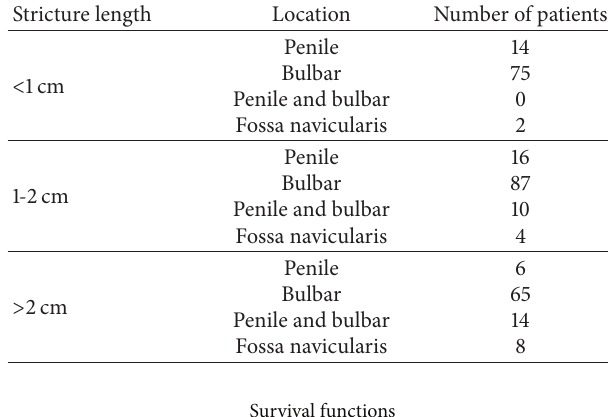
Table 1: Stricture characteristics.